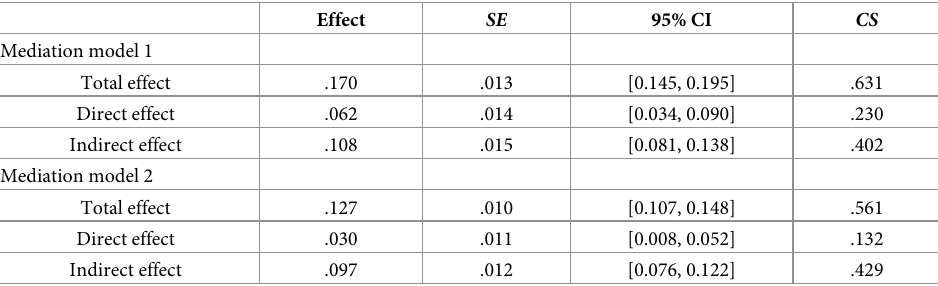
Table 2. Total, direct, and indirect effects of the mediation models. Effect SE 95%